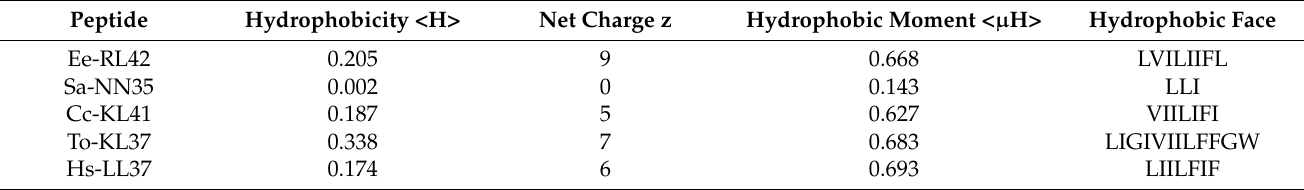
Table 2. Helix properties calculation of putative antimicrobial peptides from Eulipotyphla order, including Talpa occidentalis , obtained by the bioinformatic tool “Heliquest” (https://heliquest.ipmc.